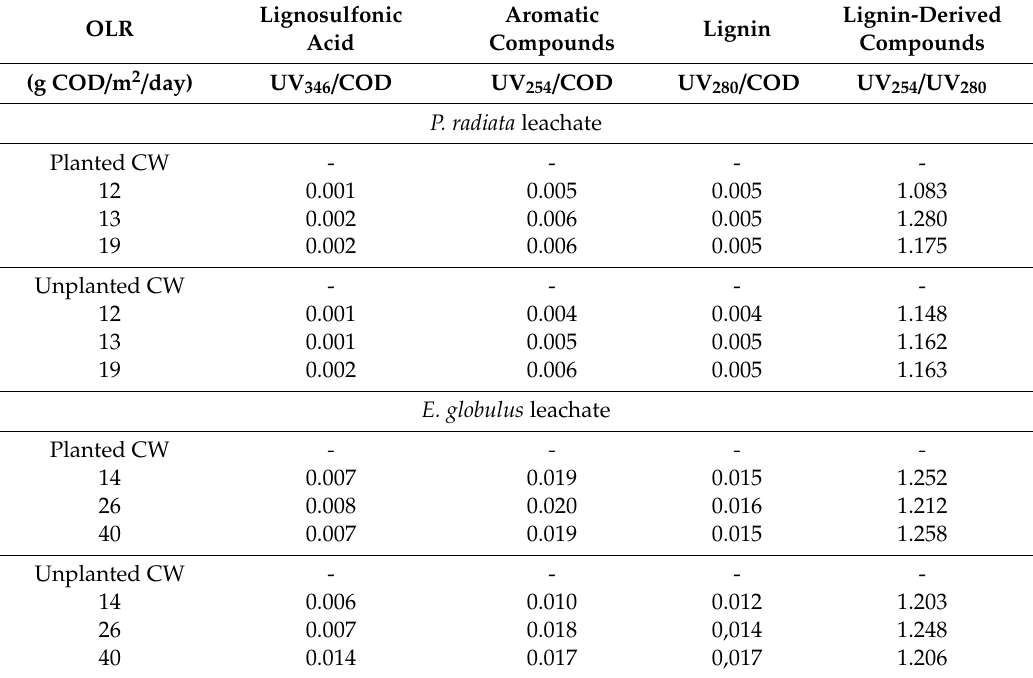
Table 3. Variations of the ratio of aromatic compounds to COD for the e ffl uents of planted and unplanted CW units treating P. radiata and E. globulus leachates (average values are shown). Lignosulfonic OLR Acid